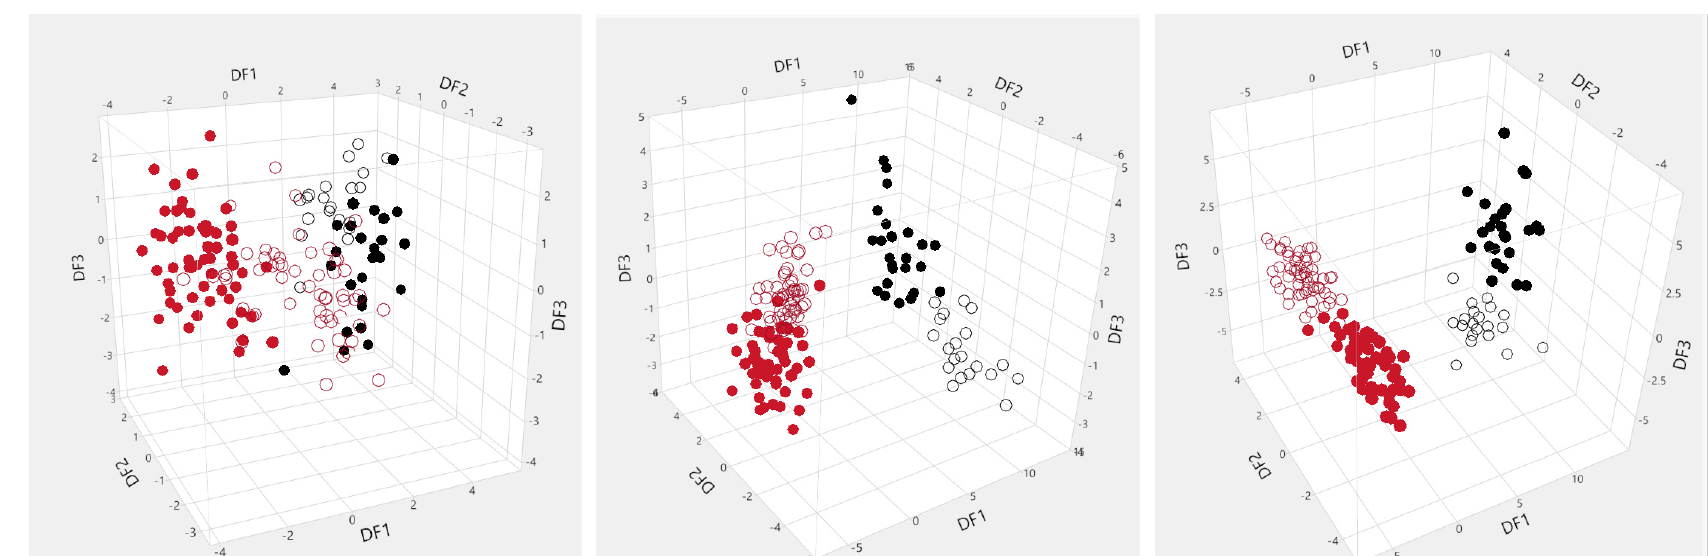
Figure 3. Distribution of discriminant scores attributed according to three discriminant functions (DF1, DF2 and DF3, respectively) applied to 160 l. thoracis samples from B. indicus and B. taurus bulls finished on grain or pasture, based on: ( a ) meat physicochemical properties; ( b ) fatty acid profiles; ( c ) physicochemical properties and fatty acid profiles. — Taurus , pasture; — Taurus , grain; — Indicus , pasture; — Indicus , grain.